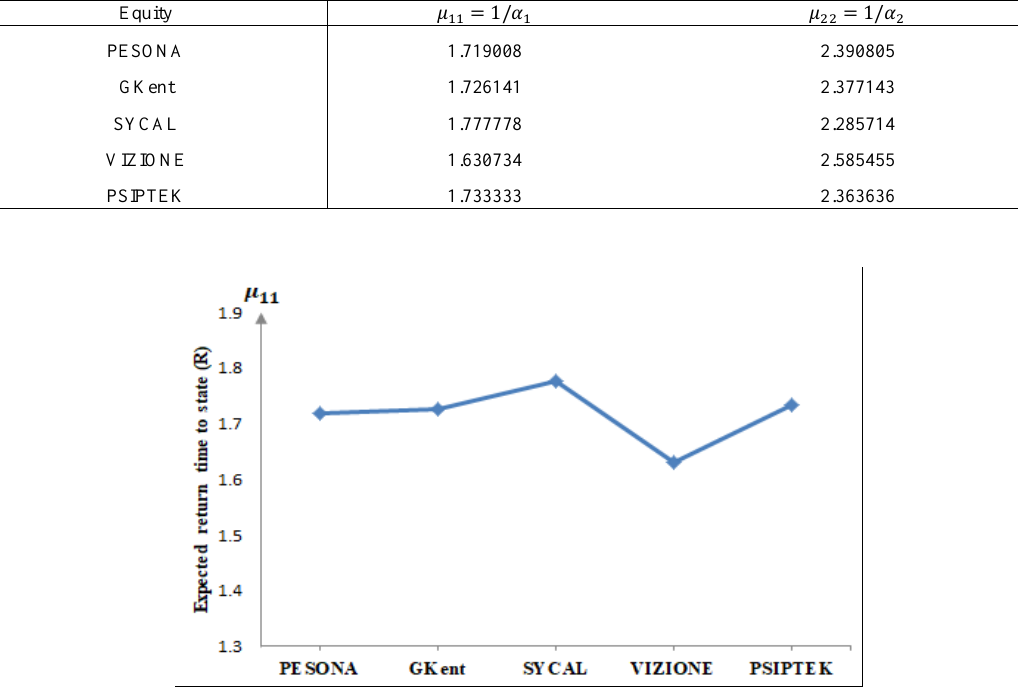
Figure 4. Mean recurrence time of selected shares for